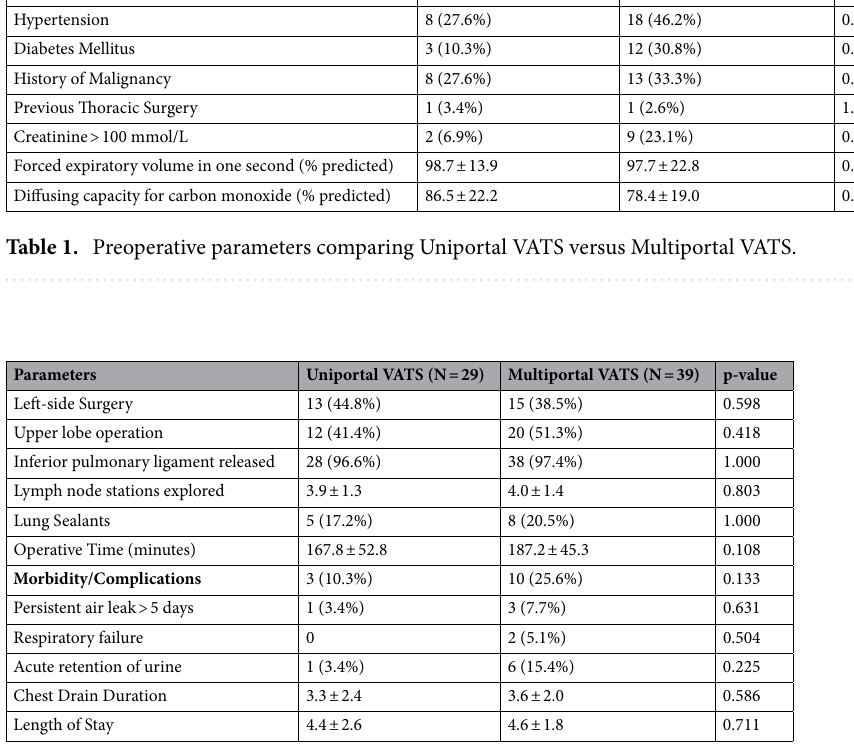
Table 2. Intraoperative and postoperative parameters comparing Uniportal VATS versus Multiportal VATS.